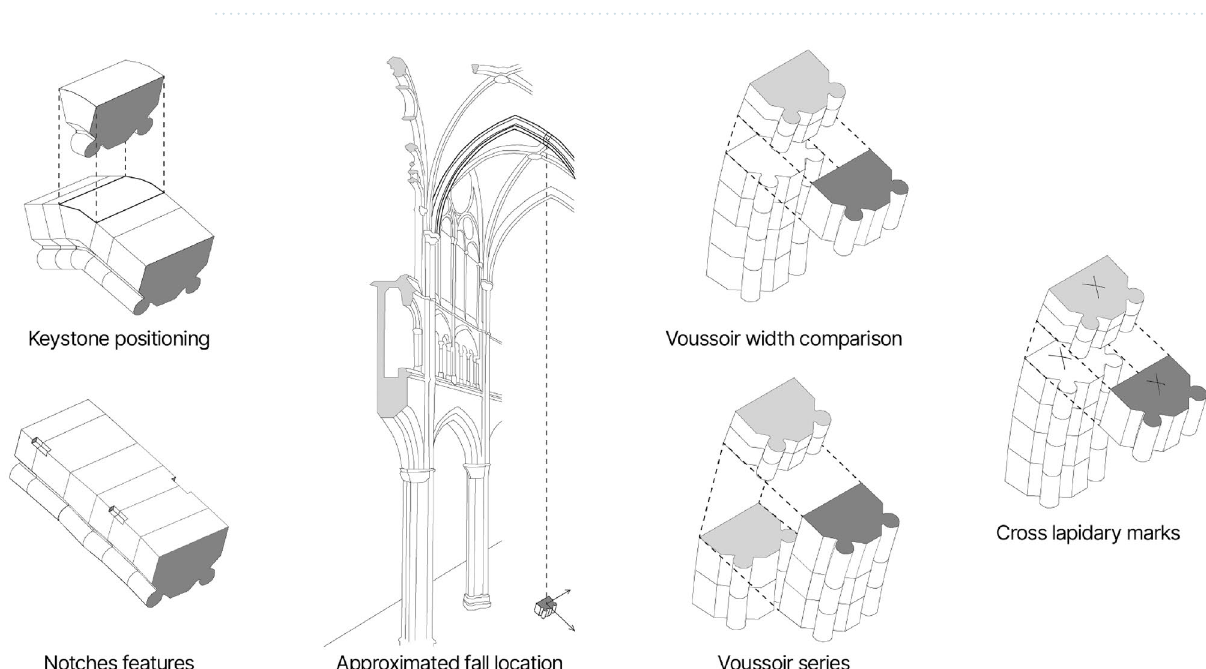
Figure 7. Set of the archeological predicates used in the reconstruction